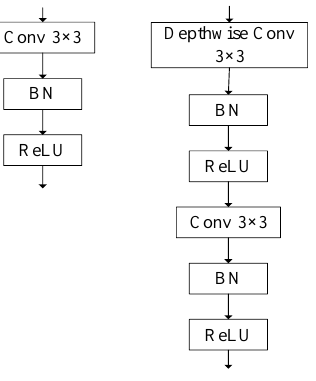
Figure 3. Conventional convolution (left) and depth- separable convolution (right)